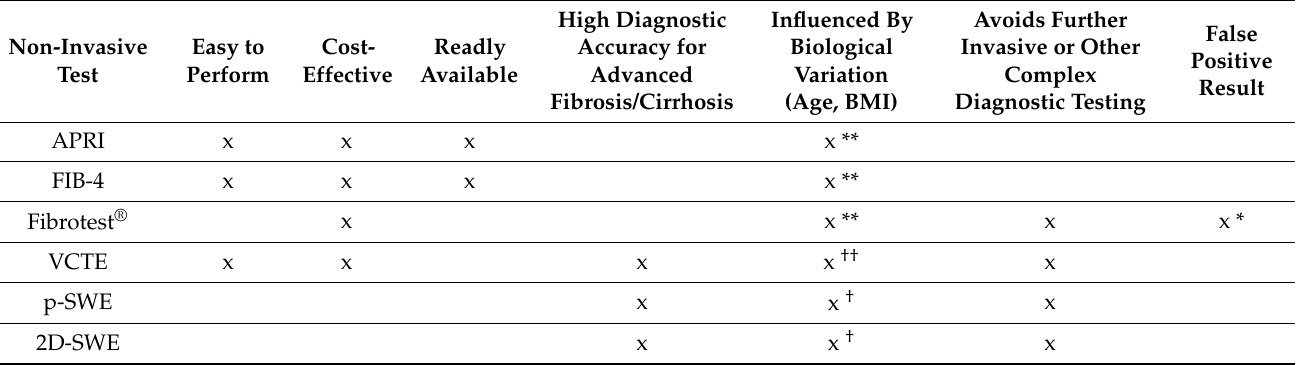
Table 2. Characteristics of the Non-Invasive Tests used in the clinical practice for staging fibrosis in chronic hepatitis